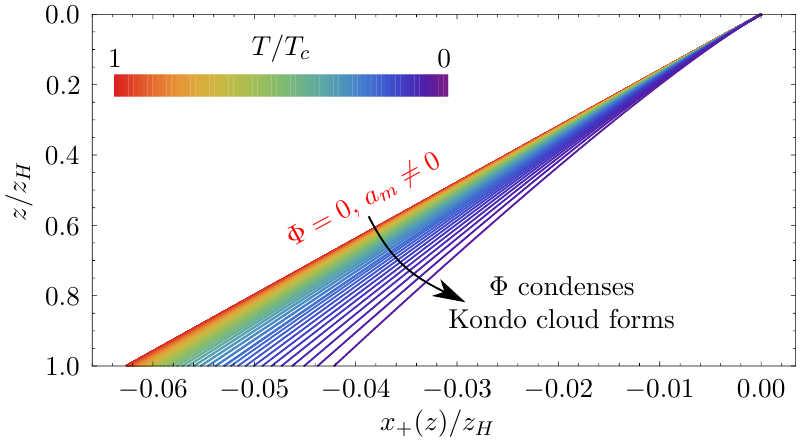
Figure 2 . Embedding pro(cid:12)les x + ( z ) for the embedding of the brane Q into the bulk spacetime (2.3). Note that the bulk spacetime N is located to the right of the curves, at larger x -values. See also (cid:12)gure 1 again. At T = T c , the scalar (cid:12)eld vanishes everywhere and the embedding is known to